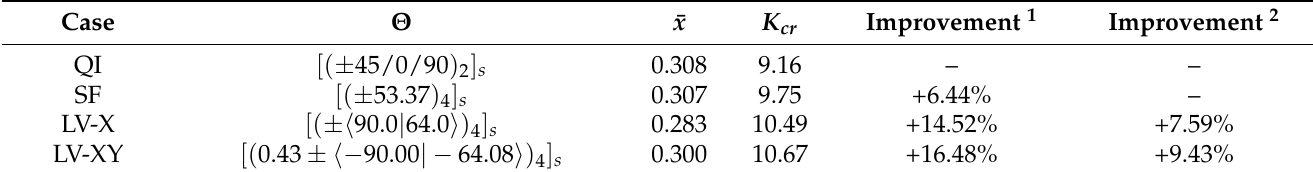
Table 7. Optimal designs and results of the stiffened plate with a central cutout subjected to in-plane shear displacements (w/ AFP manufacturing